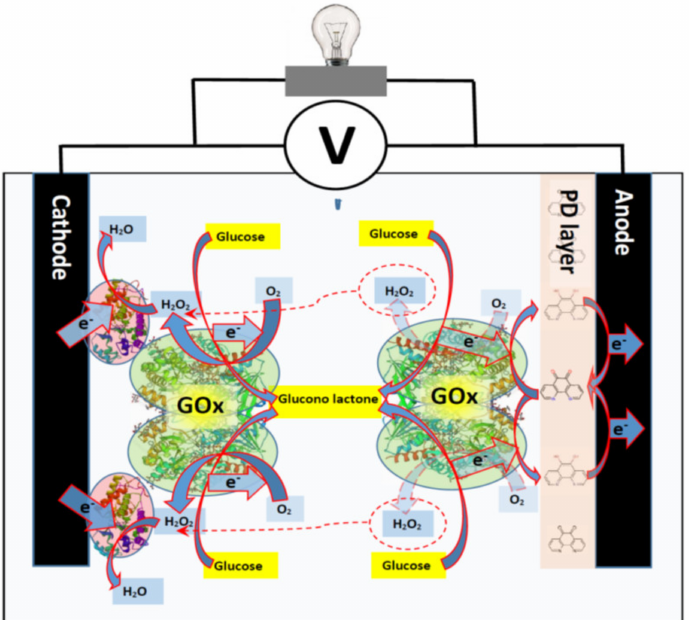
Figure 4. Enzymatic biofuel cell powered by glucose, cathode of this biofuel cell is based on co- immobilized horseradish peroxidase (HRP) and glucose oxidase (GOx) and anode is based on immobilized glucose oxidase. On anode electrons from GOx are transferred to the electrode via redox mediator power density (PD) and in cathode hydrogen peroxide created during enzymatic reaction of GOx is consumed by HRP and electrons from cathode are transferred directly to